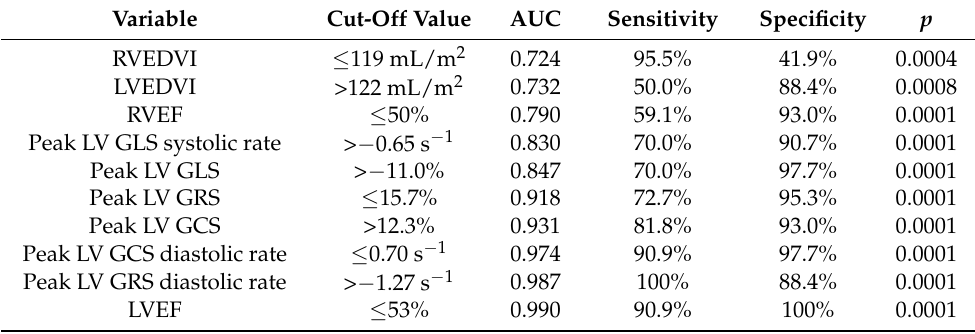
Table 3. Receiver operator characteristic curve analysis of the CMR parameters to distinguish between physiology (athlete’s heart or controls) and pathology (dilated cardiomyopathy). Variable Cut-Off Value AUC Sensitivity Specificity